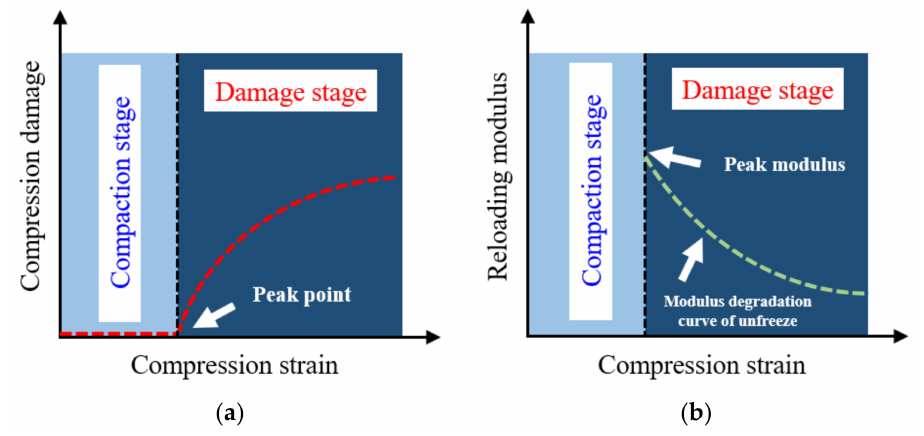
Figure 10. Compression damage model. ( a ) Relationship between compression damage and strain. ( b ) Relationship between reloading modulus and